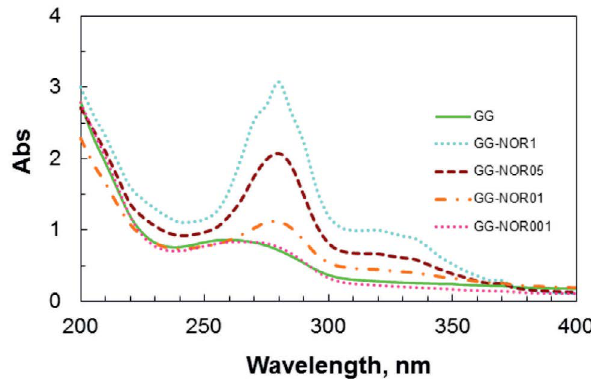
Fig. 1. UV-Visible absorbance of pure GG and GG-NOR films.